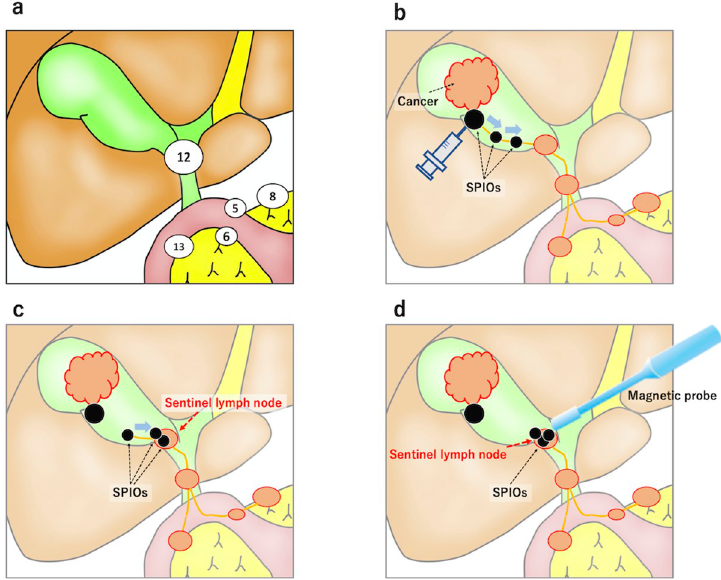
Fig 1. Regional lymph node map for gallbladder cancer and the procedure for detecting sentinel lymph nodes (SLNs) using the magnetic method. ( a ) Japanese classification of the regional lymph nodes in gallbladder cancer. Station number 5, suprapyloric nodes; 6, infrapyloric nodes; 8, nodes along the common hepatic artery; 12, nodes in the hepatoduodenal ligament; and 13, nodes posterior to the pancreatic head. ( b, c, d ) Principles of the procedure based on the magnetic detection of SLNs for gallbladder cancer using the laparoscopic magnetic probe.